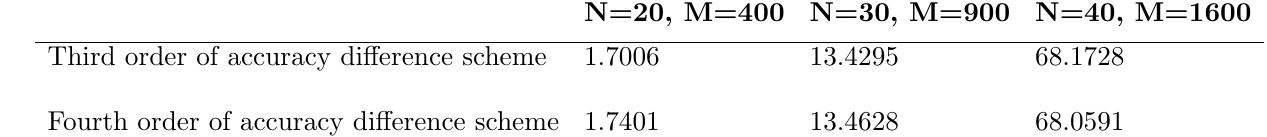
Table 6. CPU times for the approximate solutions of